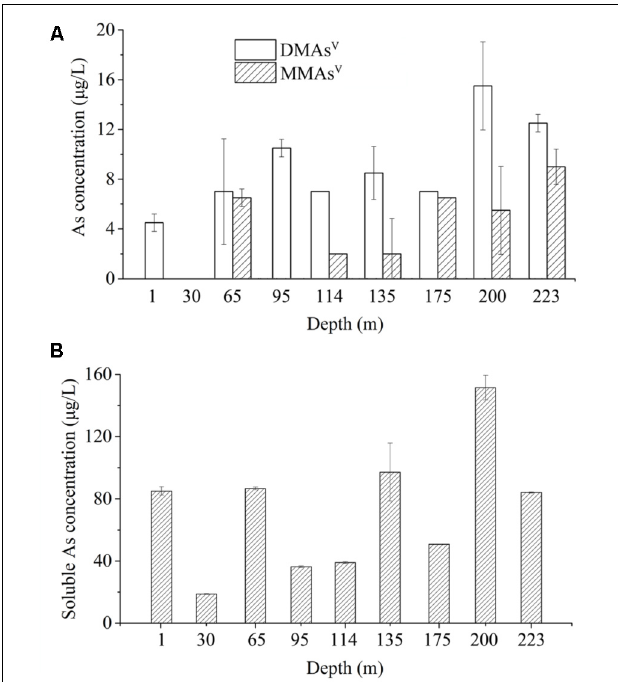
FIGURE 3 | The microbial communities-catalyzed methylation and dissolution of arsenic in the microcosms prepared from the sediment samples of the depths 1 to 223 m in the absence of exogenous As and carbon source. (A) Concentrations of biogenic methylated As after 80.0 days of incubation. (B) Concentrations of biogenic soluble As after 80.0 days of